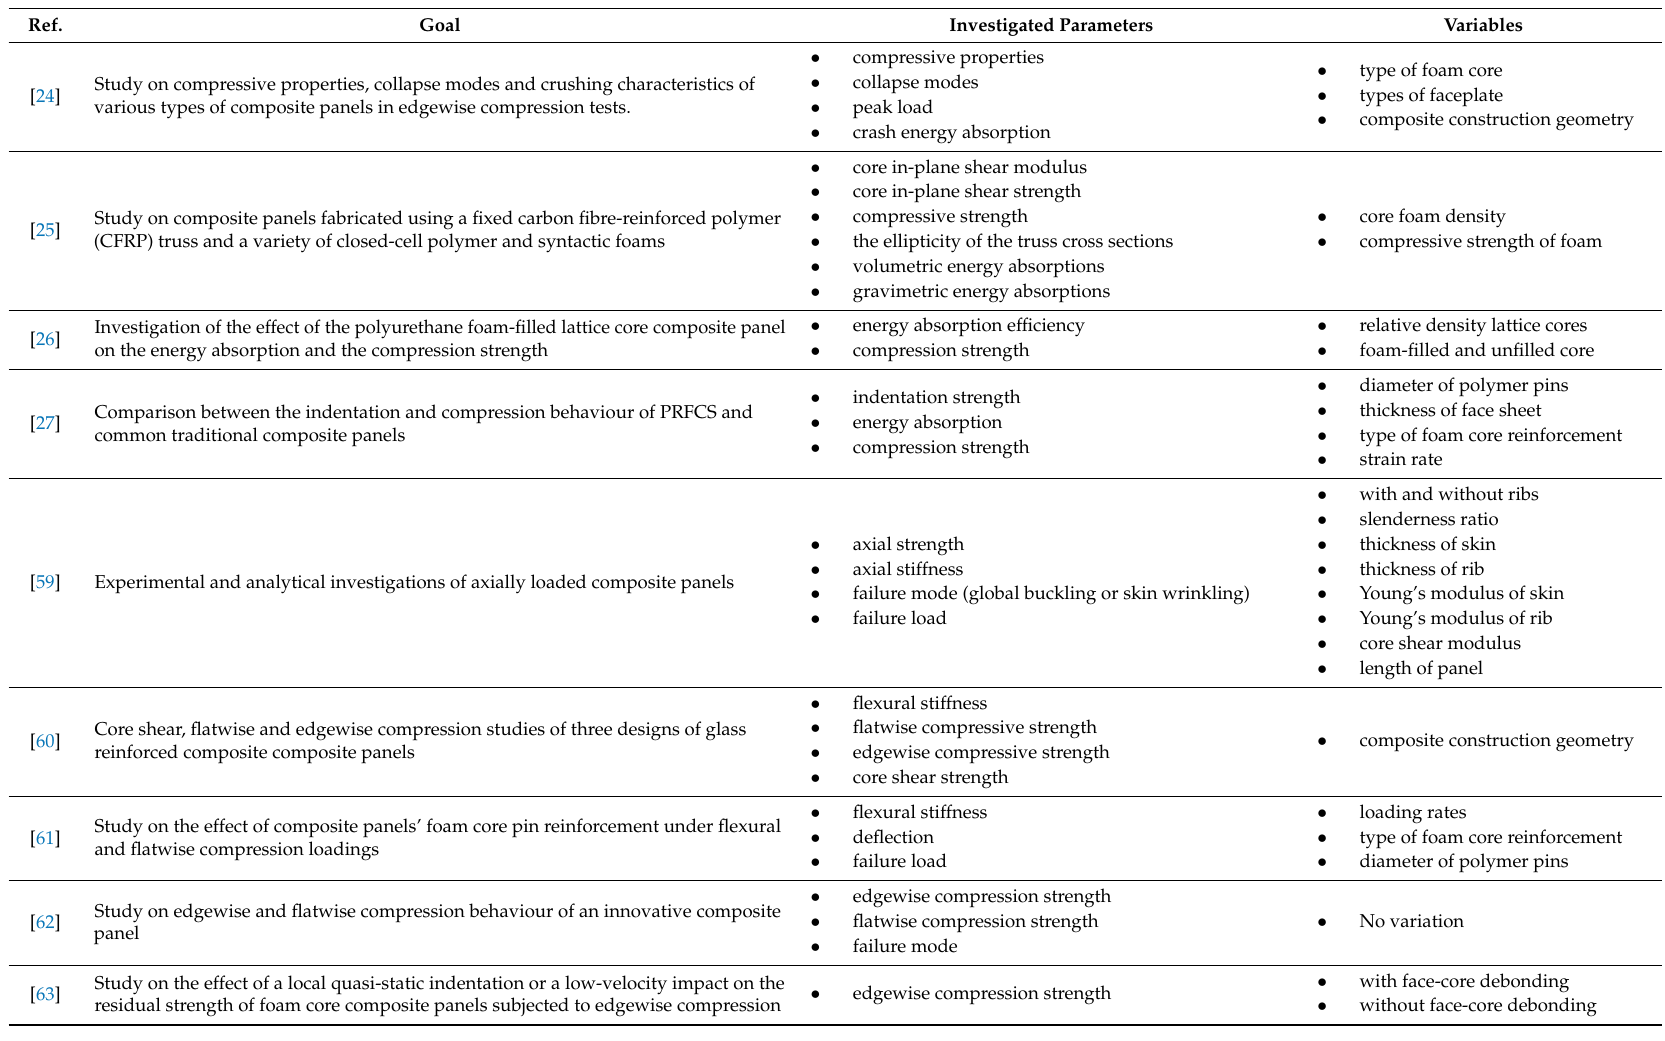
Table 3. Summary of the critical literature of edgewise and flatwise compressive/tensile behaviour of PU foam-filled composite panels.